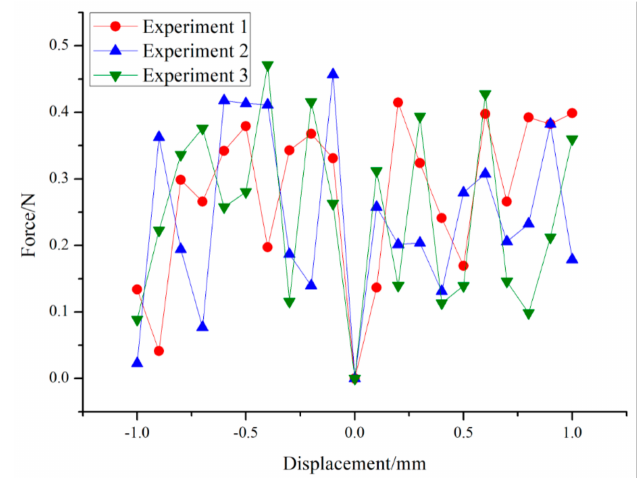
Figure 17. Internal resistance measurement experiment.